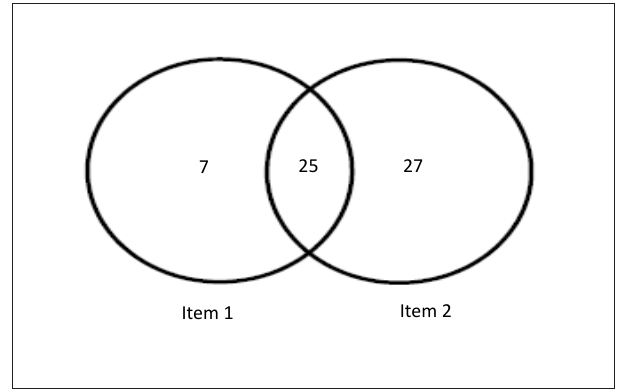
FIGURE 3: Venn diagram showing the coding evidencing the Examples TABLE 3 : Number of themes present in teachers’ responses ( N = 76). No. of themes in responses